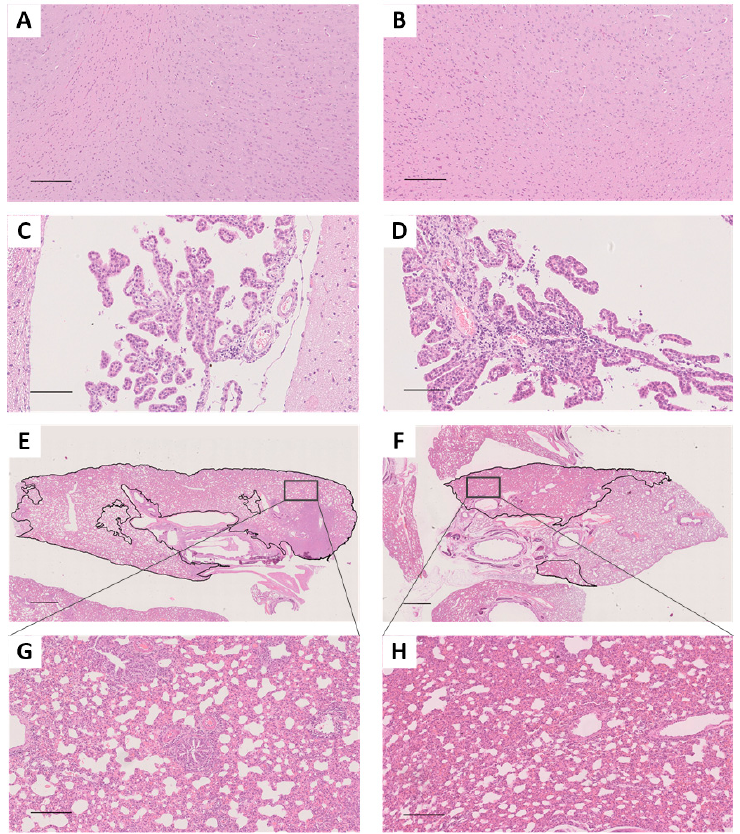
Figure 2. Hematoxylin and eosin staining of brain and lung tissue collected from ferrets at 5 d.p.i. ( A ) Brain parenchyma tissue of the Th005 infection group. ( B ) Brain parenchyma tissue of the